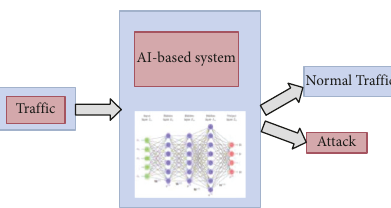
Figure 4: Overview of the proposed model.